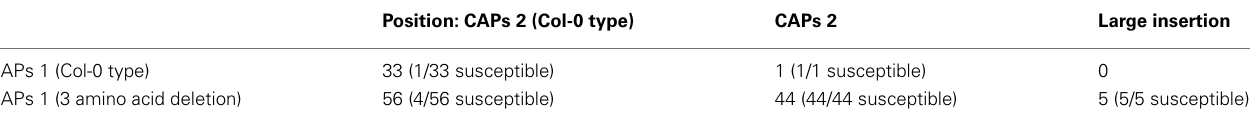
Number of accessions containing marker combinations as described in Figure A1 .The combination of CAPs marker 1 with either: (a) CAPs marker 2 or (b) a large insertion in the RPM1 gene, is associated with susceptibility in our sample of A. thaliana accessions containing the RPM1 coding